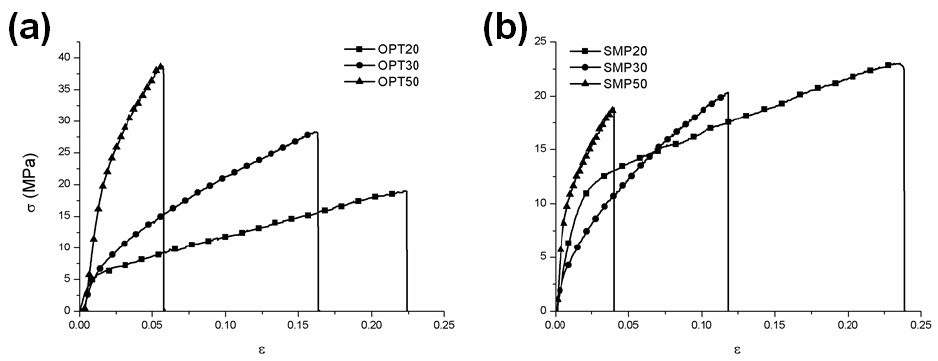
Figure 3. σ – ε curves of OPT ( a ) and SMP ( b ) based films. Table 3. Mechanical properties of the OPT- and SMP-based films, compared to the neat one (Clay- free).